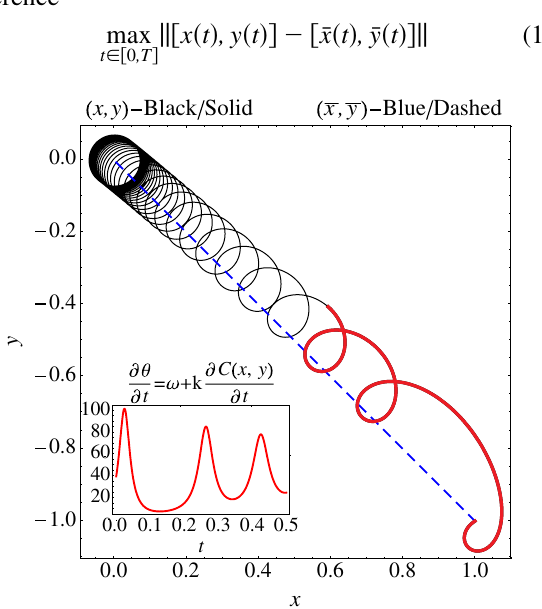
FIG. 1. The subfigure in the bottom left shows the rotation ¼ ! þ @C ð x;y Þ , for the part of the trajectory that is bold rate, @(cid:2) @t @t red, which takes place during the first 0.5 seconds of simulation. The rotation of the parameters’ velocity vector v ð t Þ slows down when heading towards the minimum of C ð x; y Þ ¼ x 2 þ y 2 , at < 0 , and speeds up when heading away from the which time k @C @t > 0 . The system ends up spending more minimum, when k @C @t time heading towards and approaches the minimum of C ð x; y Þ